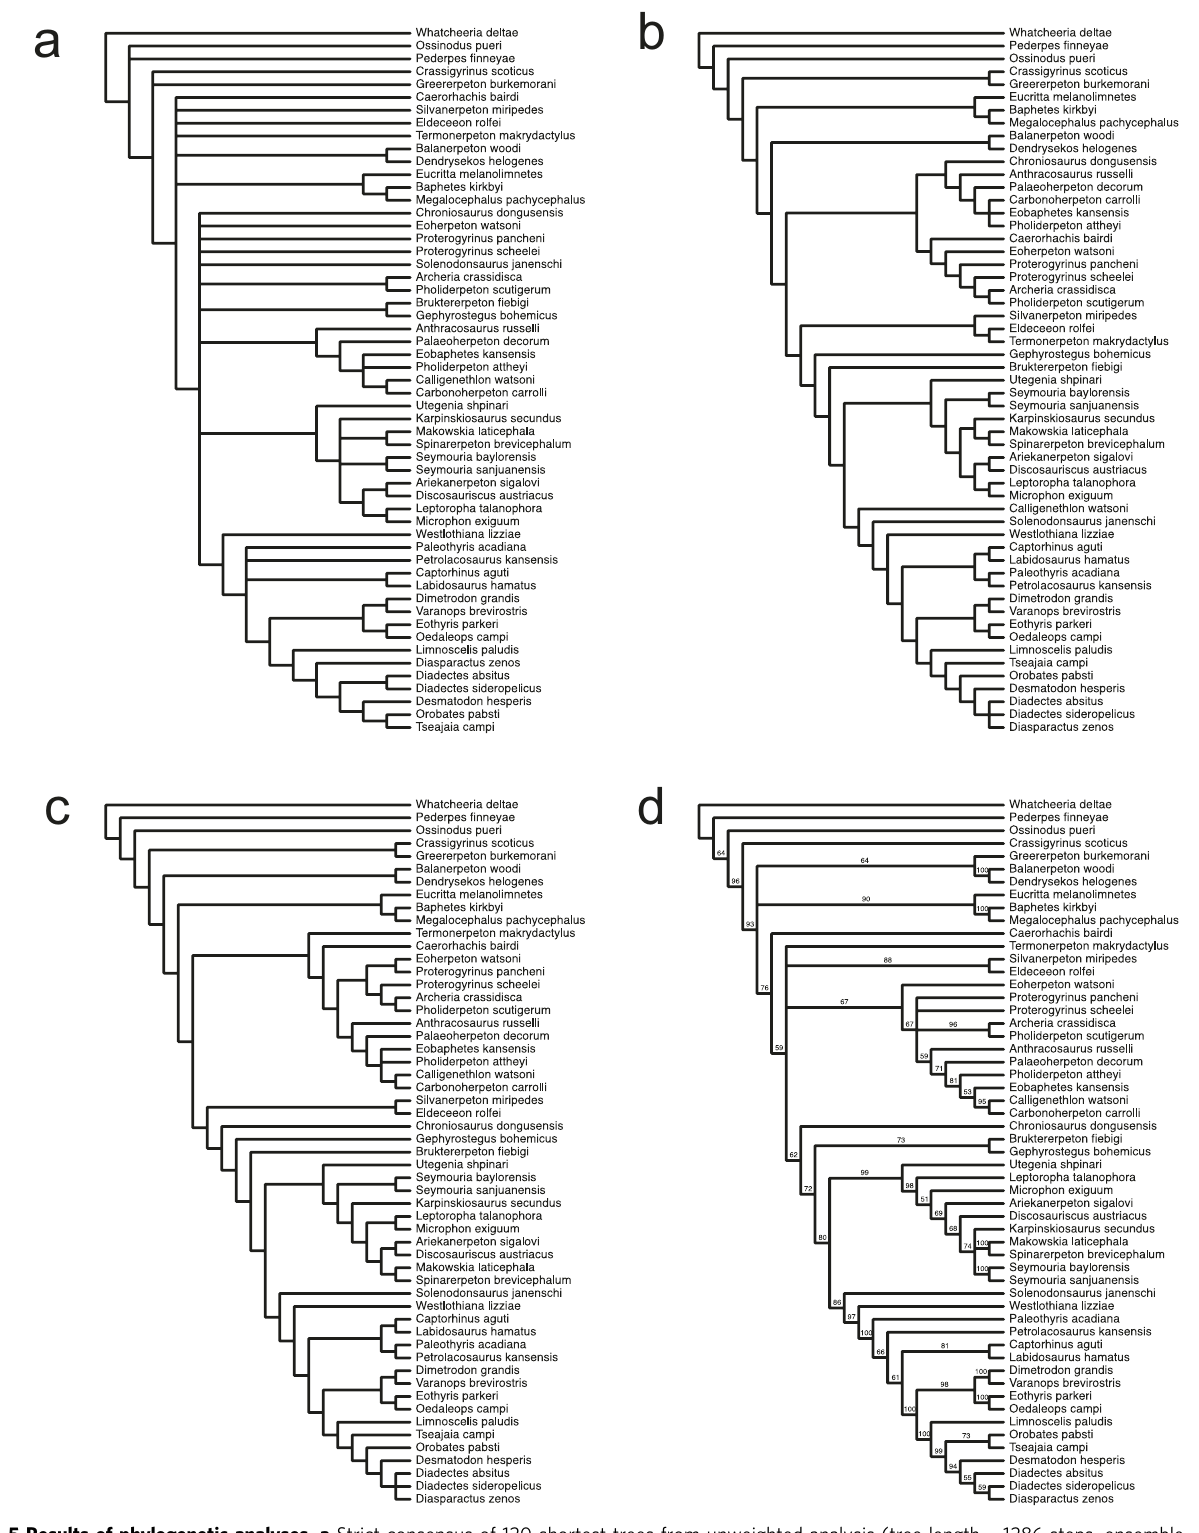
COMMUNICATIONS BIOLOGY| (2022) 5:283